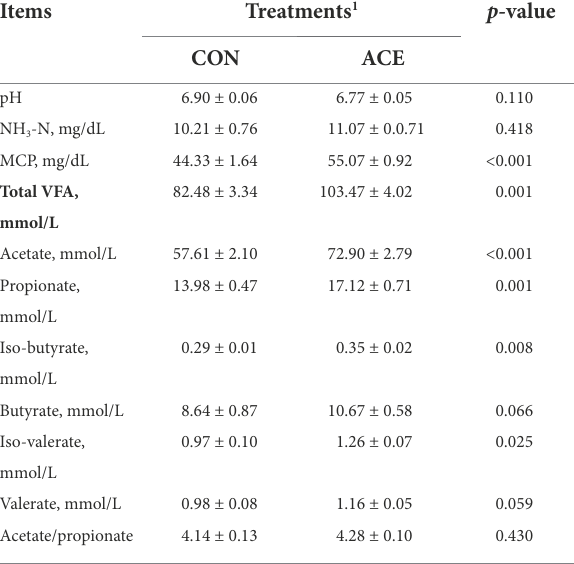
TABLE 2 Effect of NAc addition on rumen pH, NH 3 -N and volatile fatty acids